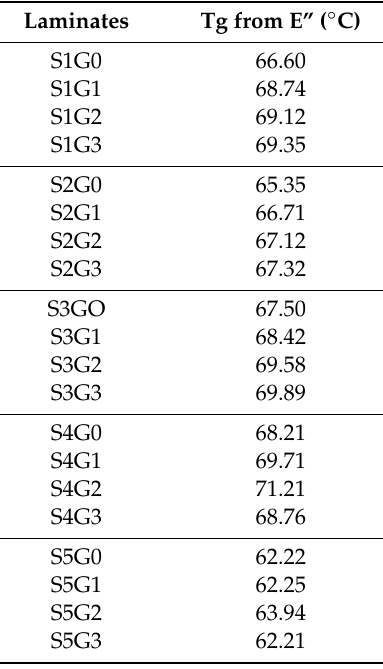
Table 3. Glass transition temperature (T g ) and Tan δ peak of laminated